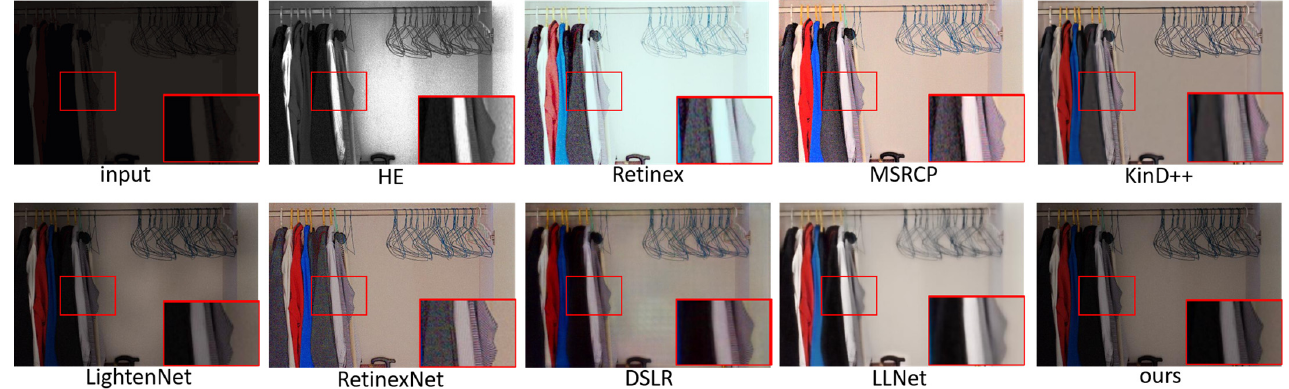
Figure 4. Visual comparison of enhanced renderings of low-illumination images.